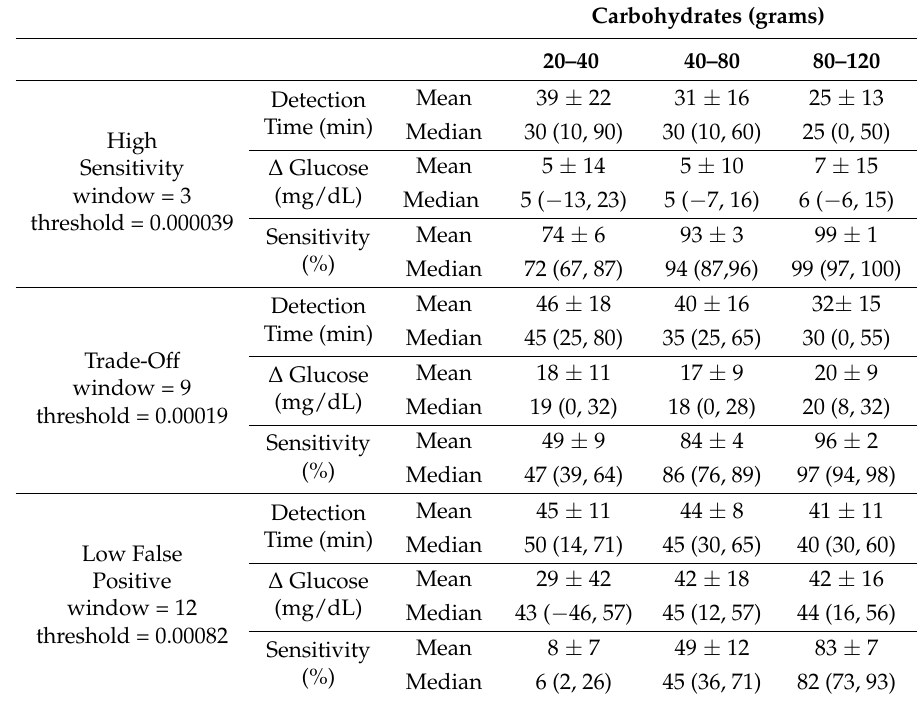
Table 4. Analysis of the effect of carbohydrate quantity on detection time, ∆ glucose, and